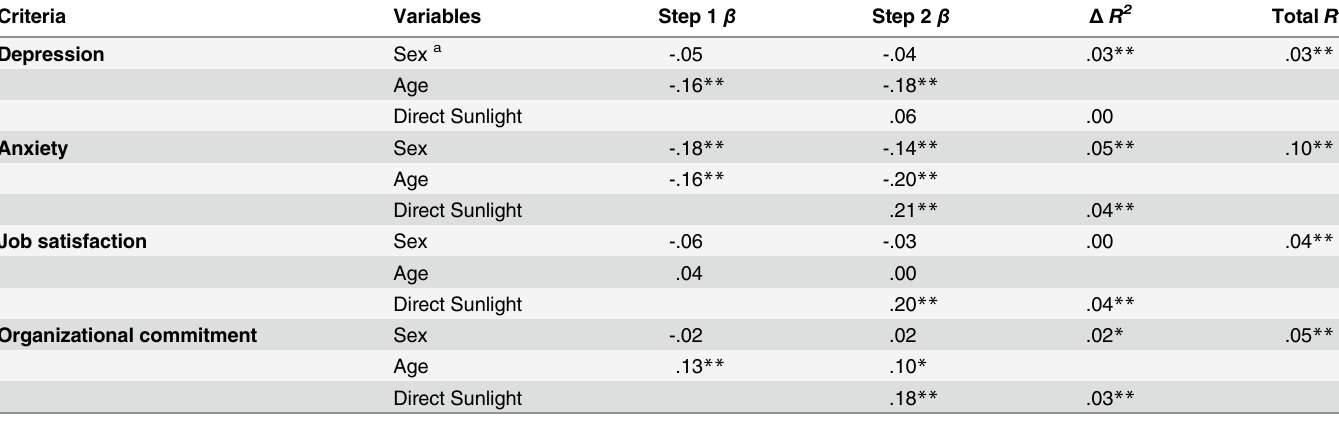
Table 5. Effects of direct sunlight exposure on outcome variables. Criteria Variables Step 1 β